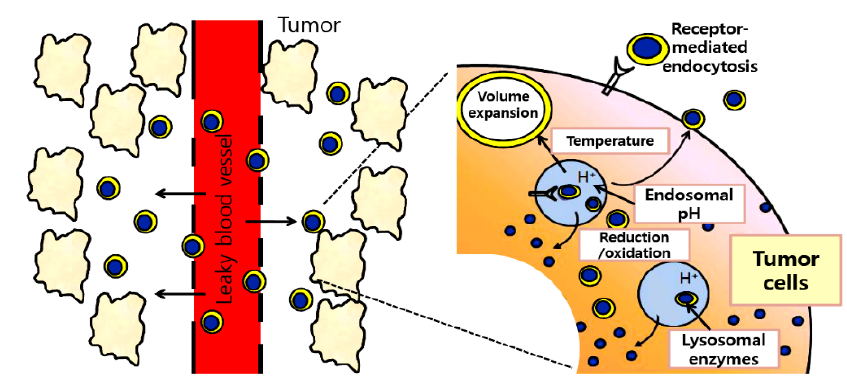
Figure 1. Schematic illustration of actions of the stimuli-responsive nanocarriers in the tumor site. Nano-sized drug carriers will be extravasated into tumors and internalized into tumor cells using pinocytosis, receptor-mediated endocytosis, and other internalized mechanisms. The drug release kinetics from nano-sized drug carriers internalized into the cells may be modulated by stimuli, such as pH, enzymes concentrations, and temperatures, to enable effective cytosolic drug